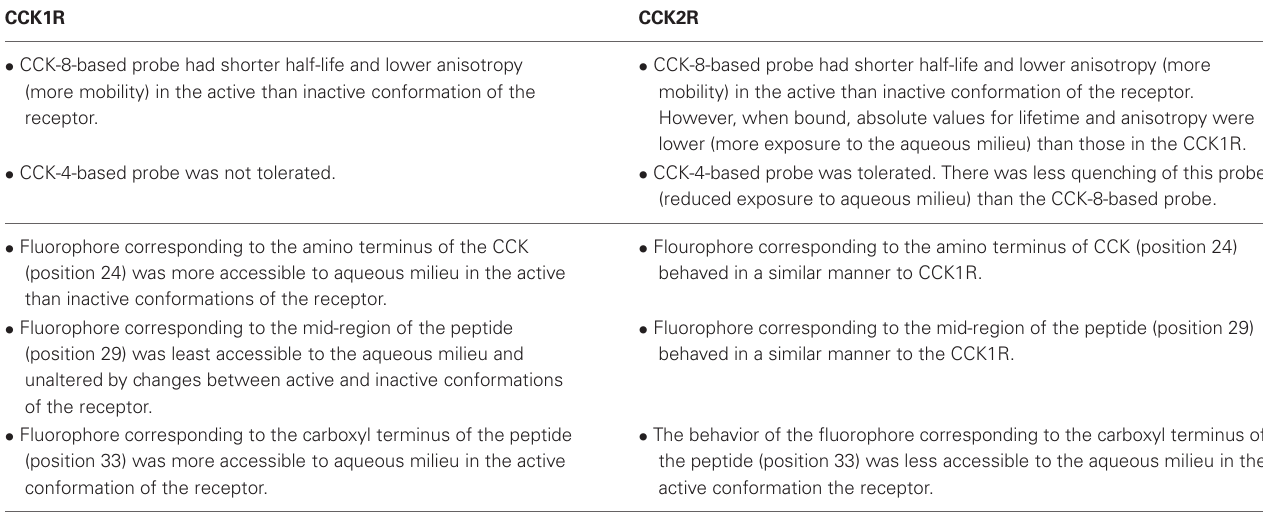
Table 2 | Summary of studies demonstrating the differential binding of fluorescent CCK probes to CCK1 and CCK2 receptors. CCK1R